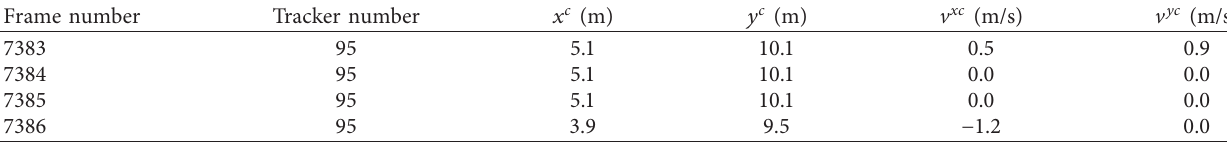
Table 4: Motion state